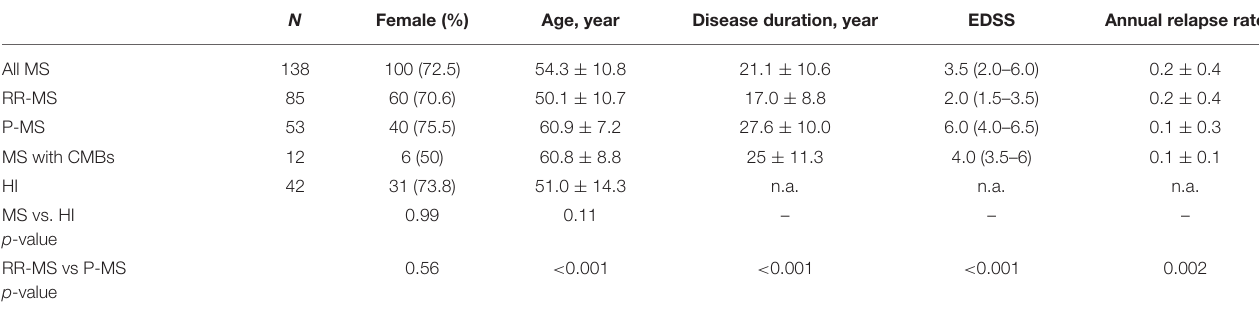
TABLE 1 | Demographic and clinical characteristics of the